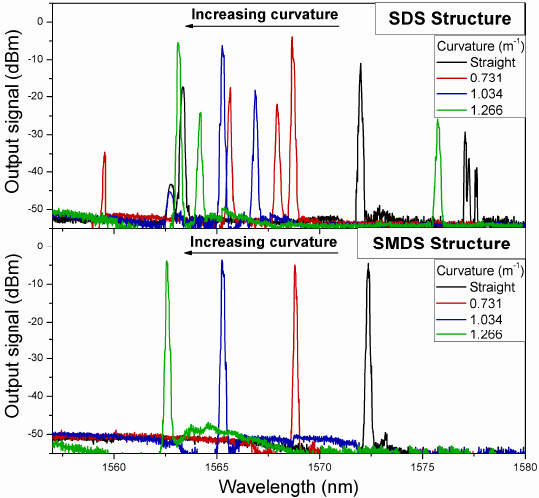
Figure 6. The output signal of the EDFL under curvature variations for SDS and SMDS structures used as spectral filters.